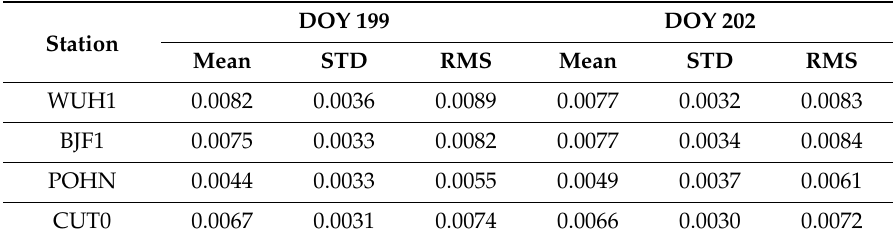
Table 2. Statistics of the STD of the observation residual during the non-maneuvering period (m).